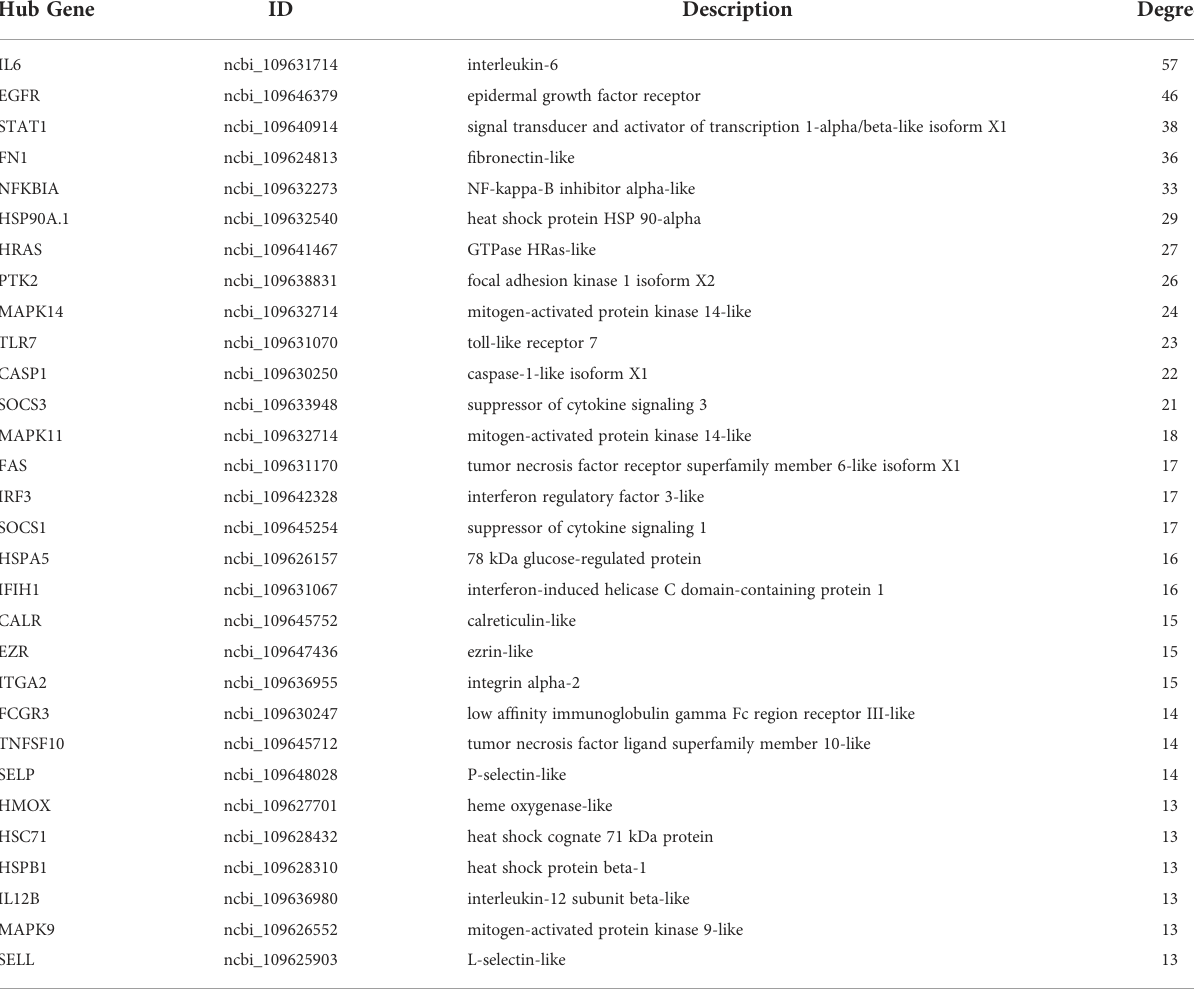
TABLE 10 Description and degree of connectivity of the 30 immune-associated upregulated hub genes on day 7 after challenge. Hub Gene ID Description